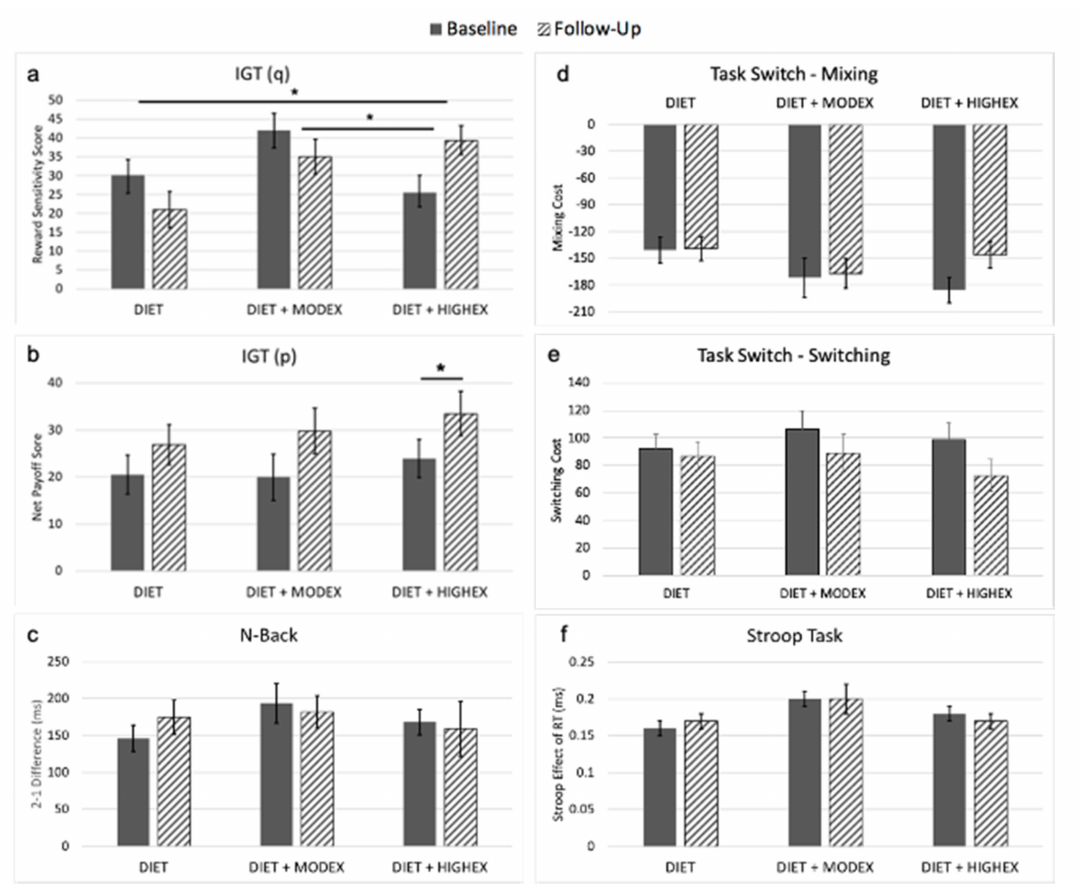
Figure 2. Cognitive performance for each group before and following the intervention. Error bars represent standard error. ( a – f ) show the individual cognitive change from baseline to follow-up assessments. Note: * indicates that the post-hoc comparison was significant at the p < 0.05